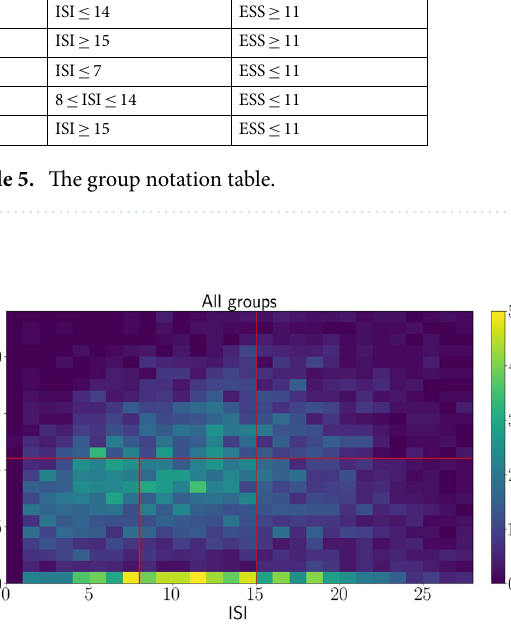
Figure 1. The distribution of total subjects.